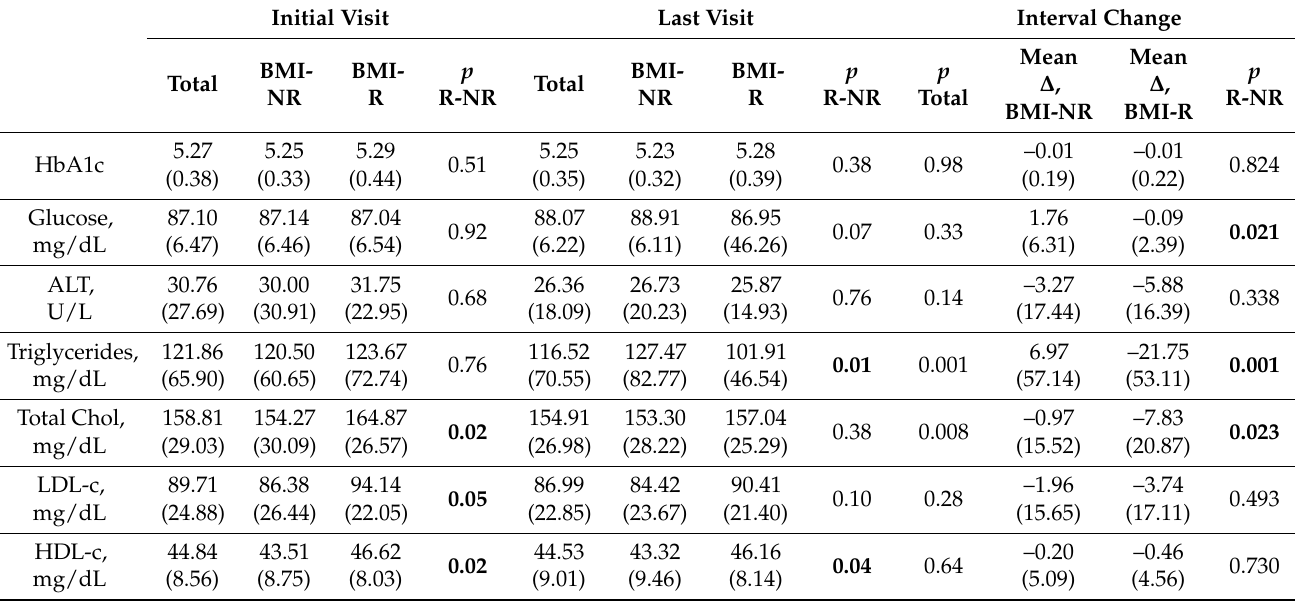
Table 3. Prevalence of Metabolic